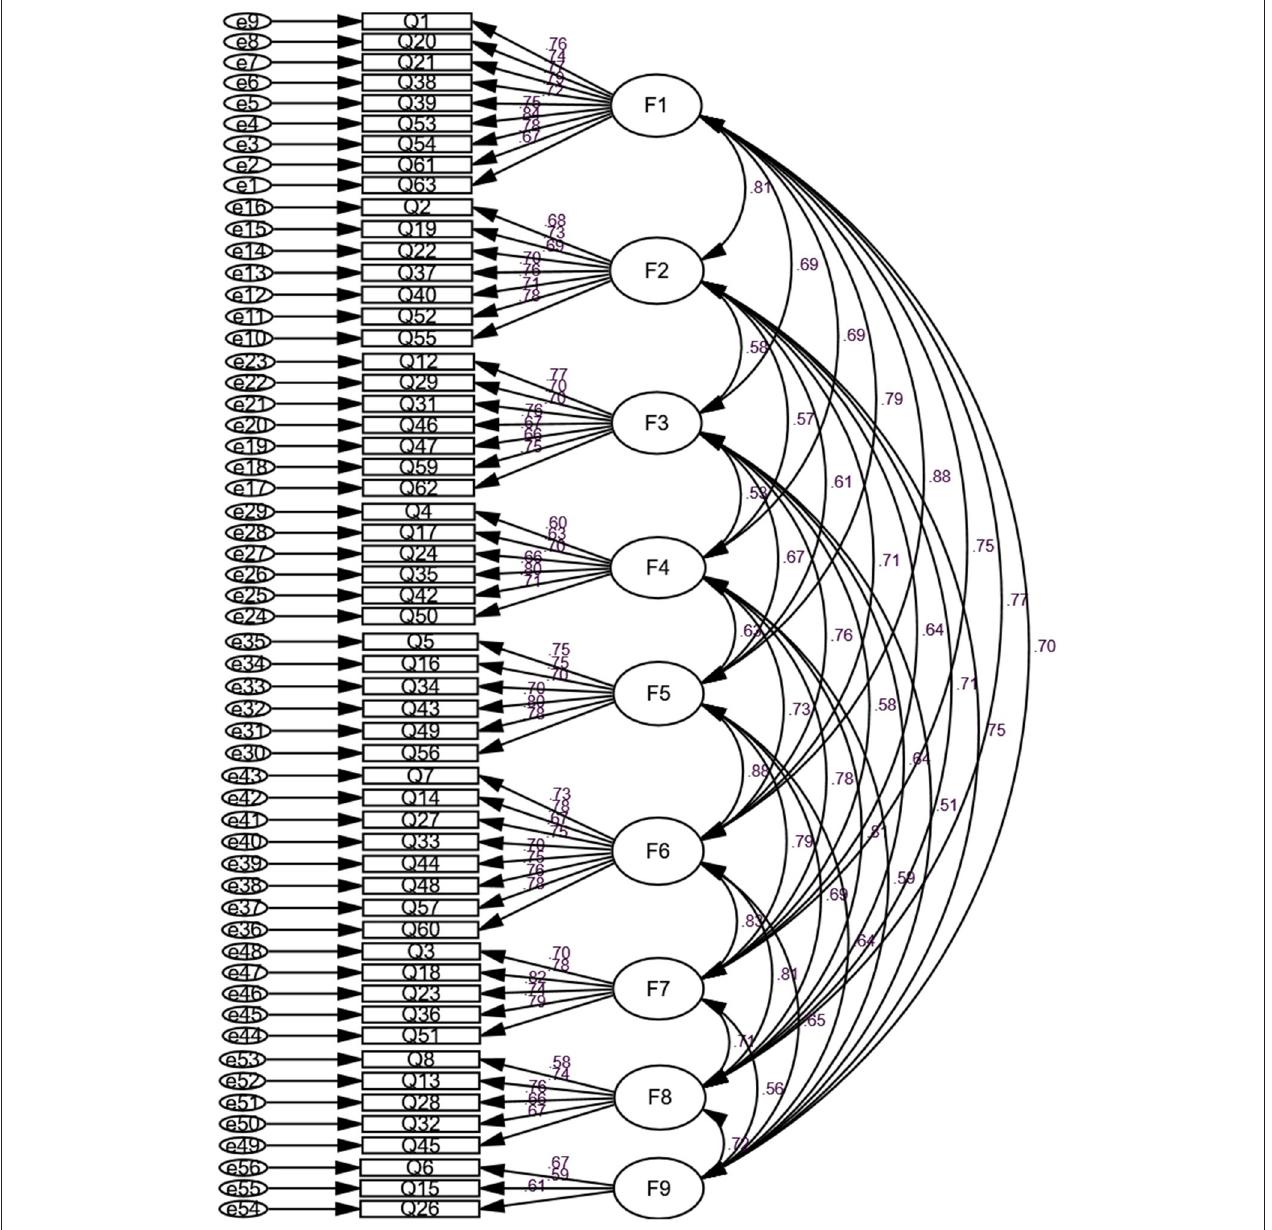
FIGURE 1 | Path diagram and estimated parameter loadings for the nine-factor model of the college students’ experience of family harmony questionnaire (CSEFHQ) ( N = 696). Latent variables (factors F1–F9) are indicated with ovals, and observed variables (items Q1–Q63) are indicated with